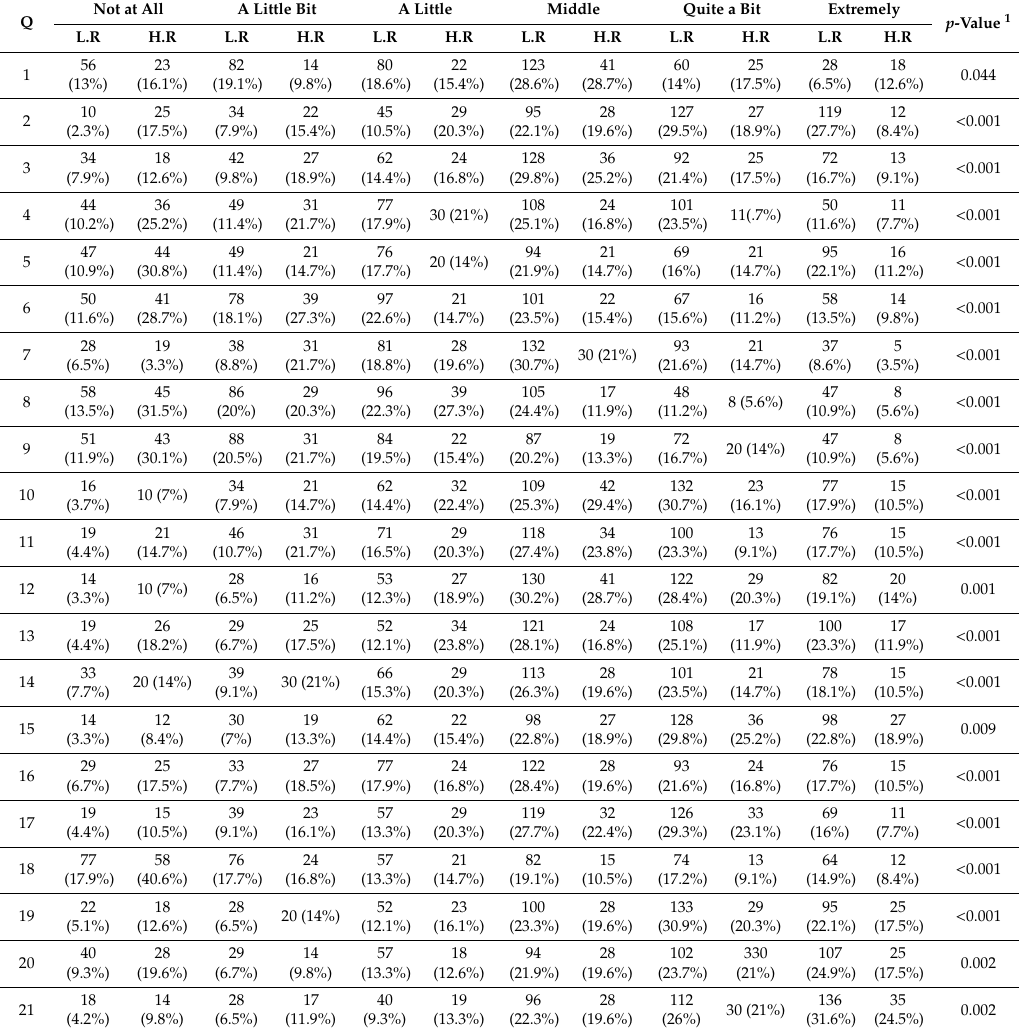
Table A3. Frequency of the Post-Traumatic Growth Inventory (PTGI) in low-risk (L.R) and high-risk (H.R) groups (Cut-o ff =